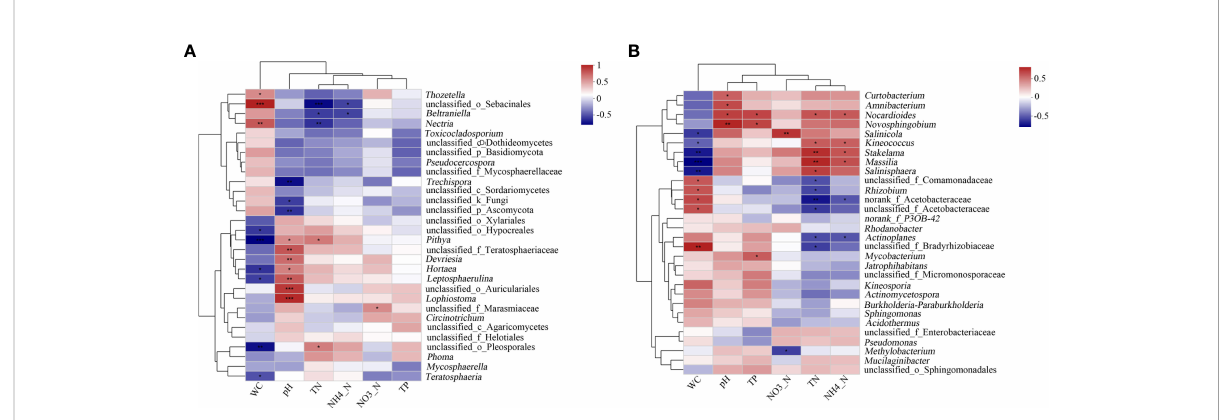
FIGURE 7 Heat map showing the correlation of litter properties to the top 30 fungal and bacterial genera. X and Y axes represent the environmental factors and genera, respectively. R in different colors to show. *0.01< P ≤ 0.05, **0.001 < P ≤ 0.01,***P ≤ 0.001. (A) Fungi; (B)